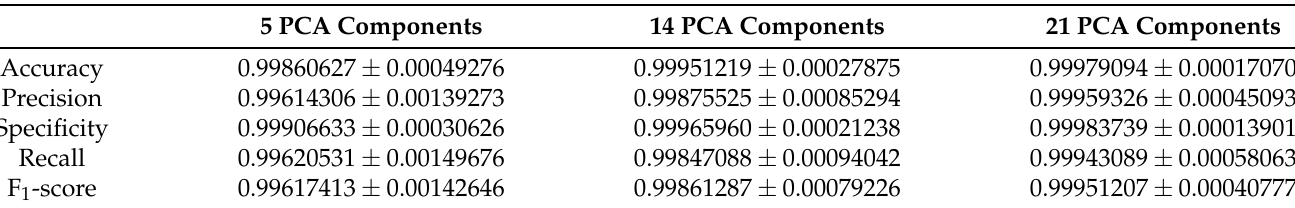
Table 7. Averaged performance measures of the XGBoost classifier when varying the number of principal components d along with its associated standard